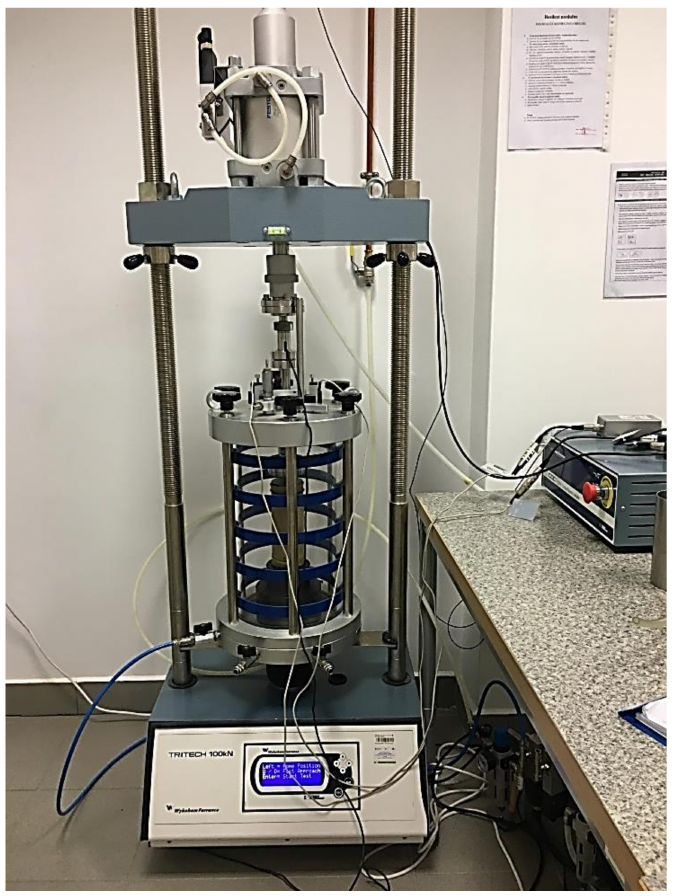
Figure 5. View of the cyclic triaxial apparatus with the sample in a cell before starting the test. Samples were subjected to cyclic loading tests to determine the resilient modulus M r subgrade material. Sequence 0 is the conditioning of the sample. In the next 15 sequences, the confining pressures ranged from 20.7 to 137.9 kPa and the maximum axial stresses ranged from 20.7 to 275.8 kPa. The resilient modulus M r for sequences from 1 to 15 was calculated as the average value from the past five cycles of each load